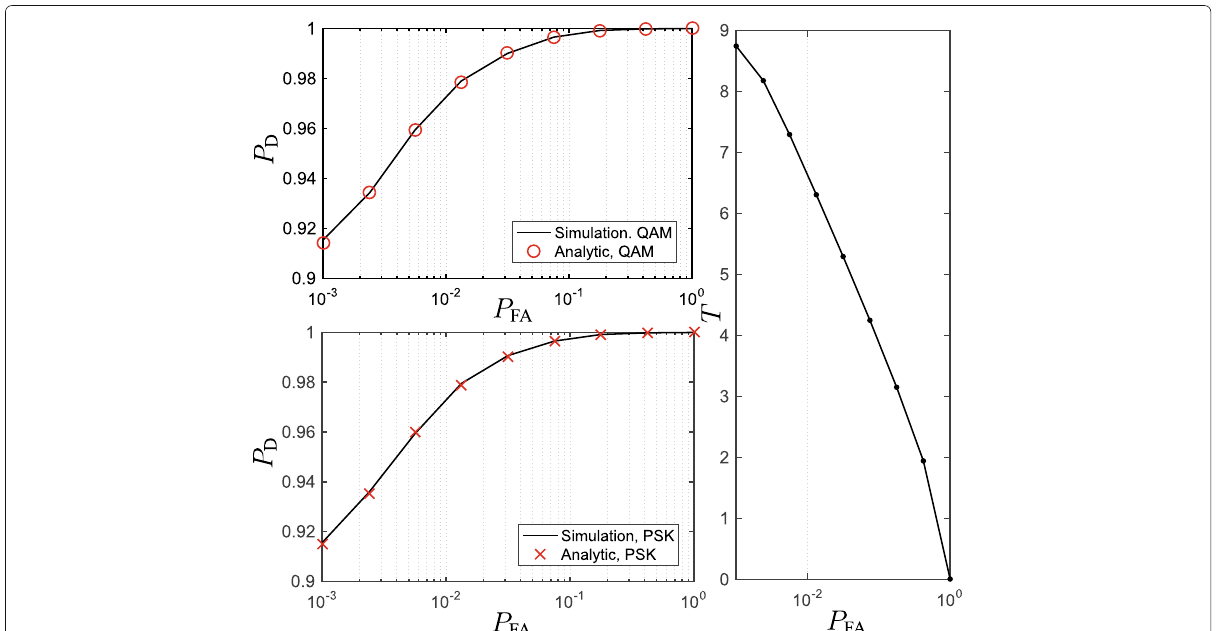
Fig. 6 Analytical and simulated P D vs. P FA and corresponding T . The current AF relay (α rx , θ rx , α tx , θ tx ) = ( − 0.03,5 ◦ ,0.05,4 ◦ ) , the pre-registered AF relay (α rx , θ rx , α tx , θ tx ) = ( 0.02,5 ◦ , − 0.05, − 4 ◦ ) , σ 2 = 0.1, N = 14